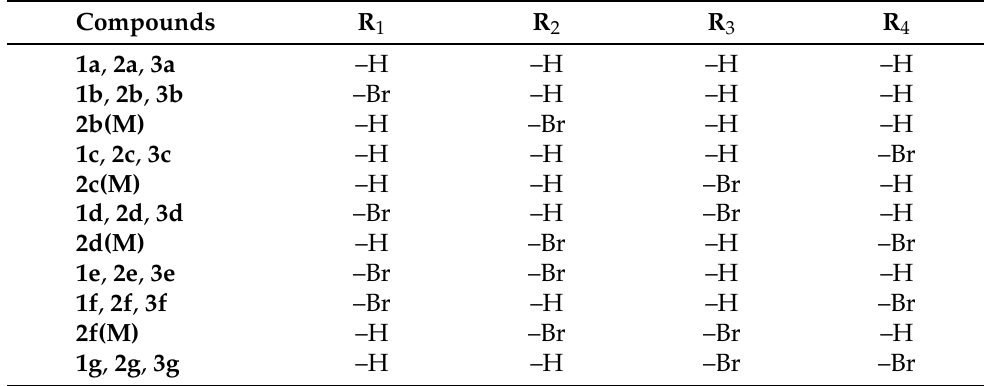
Figure 1. 1,4-Naphthoquinone and its derivatives with atom numbering scheme: carbon—blue, oxygen—green and bridge hydrogen—red. The dotted lines indicate the presence of intramolecular hydrogen bonds. R 1 , R 2 , R 3 , R 4 indicate the position of –H and –Br. The details of the substitution are presented in Table 1. Table 1. Arrangement of substituents in the studied compounds—see Figure